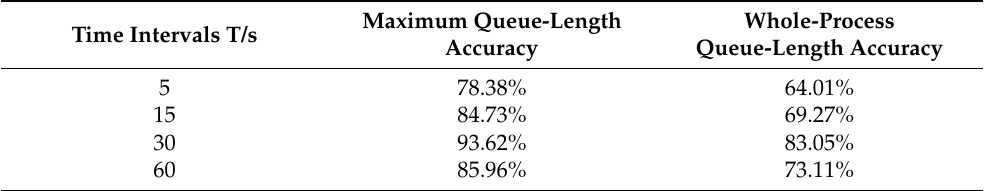
Figure 15. Comparison of vehicle queue length at different time intervals and measured queue length. ( a ) The time interval T is 5 s, ( b ) The time interval T is 15 s, ( c ) The time interval T is 30 s, ( d ) The time interval T is 60 s. Table 4. Comparison of accuracy rate at different time